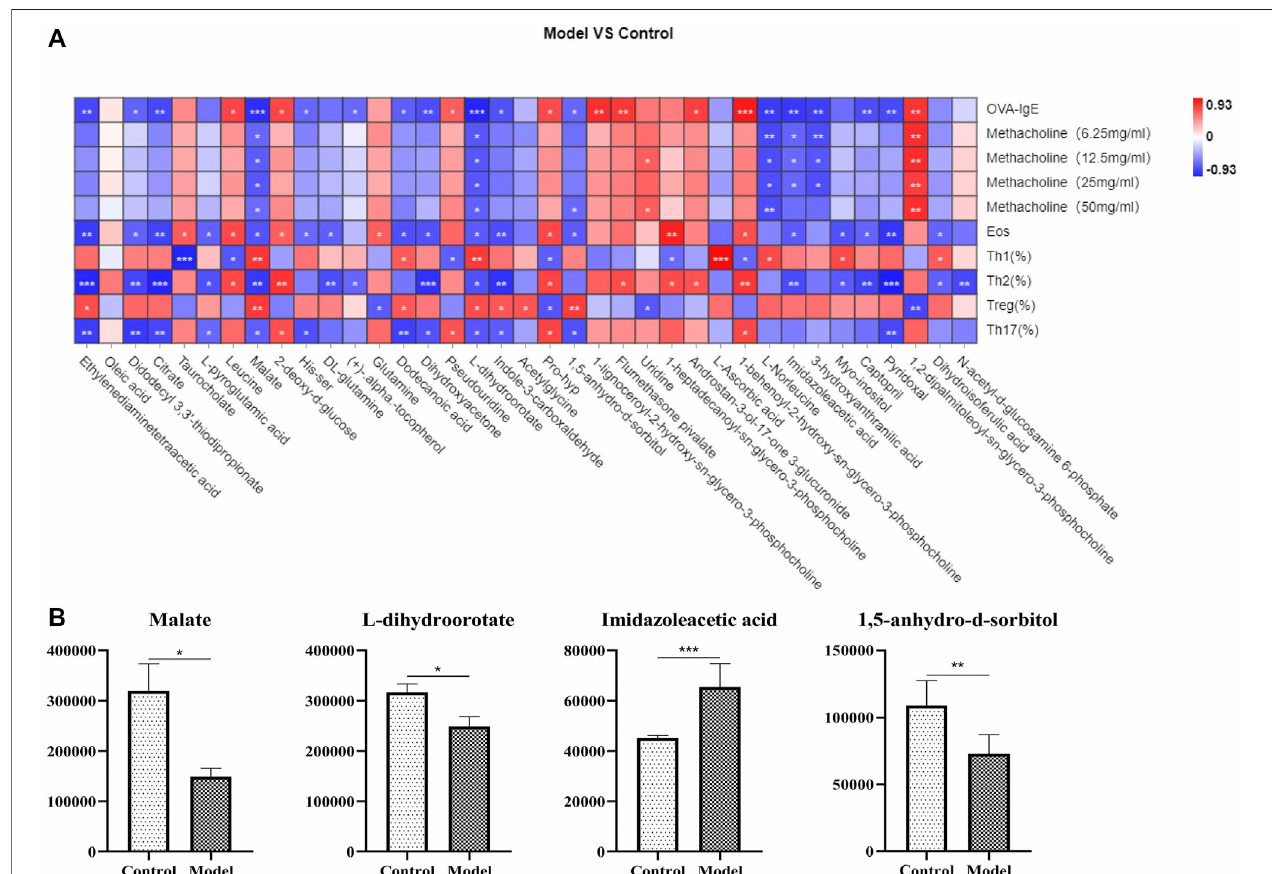
FIGURE 5 | Correlation analysis of metabolic biomarkers and Th1, Th2, Treg, Th17 cells in OVA induced eosinophilic asthma model. (A) Correlation plot showing the relationship between the differential metabolites in plasma and the key immune indicators of eosinophillic asthma including OVA-IgE, Penh value and eosinophil number in BALF. (B) Biomarkers of metabolic biomarkers in eosinophilic asthma associated with Th1, Th2, Treg and Th17 cells, followed by Malate, L -dihydroorotate, Imidazoleacetic acid and 1,5-anhydro-d-sorbitol. * p < 0.05, ** p < 0.01, *** p ≤ 0.001. All the values are expressed as mean±SEM. n = 7 animals per group.